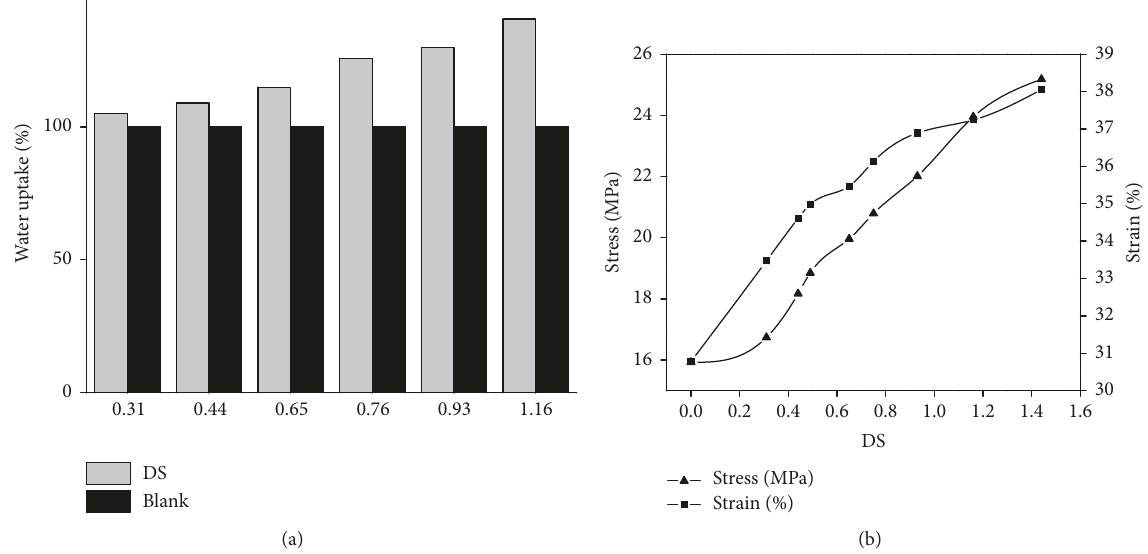
Figure 5: (a) Effect of the DS of the product on the water uptake; (b) mechanical property of the TiO 2 /BC/CHPTAC-OH/PVA membranes with different